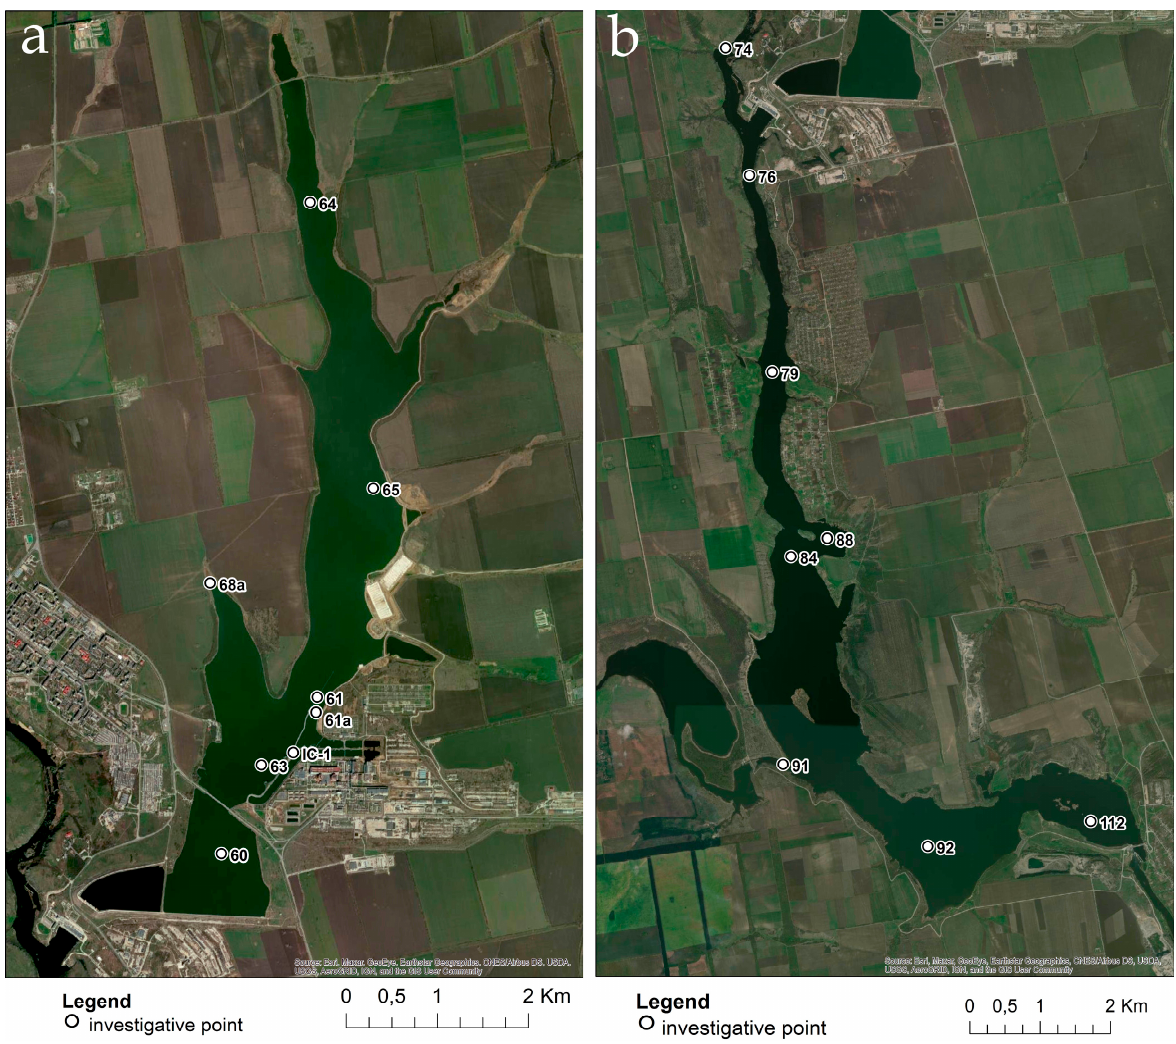
Figure 1. Location of research stations in the water area of the Tashlyk ( a ) and Alexandrovskoye ( b ) reservoirs on a fragment of the satellite image Sentinel-2 (for 30 August 2020).